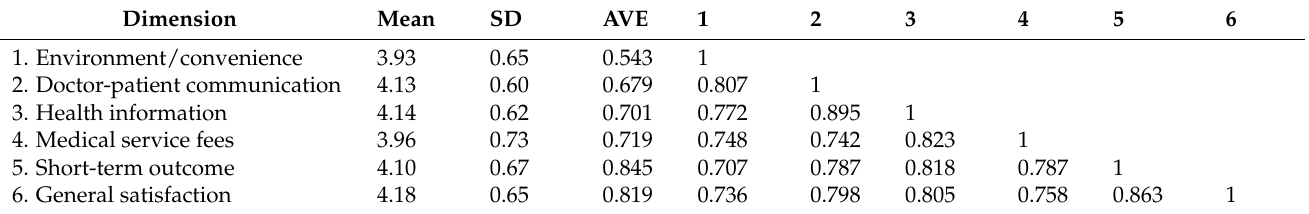
Table 4. Correlation matrix with AVE.